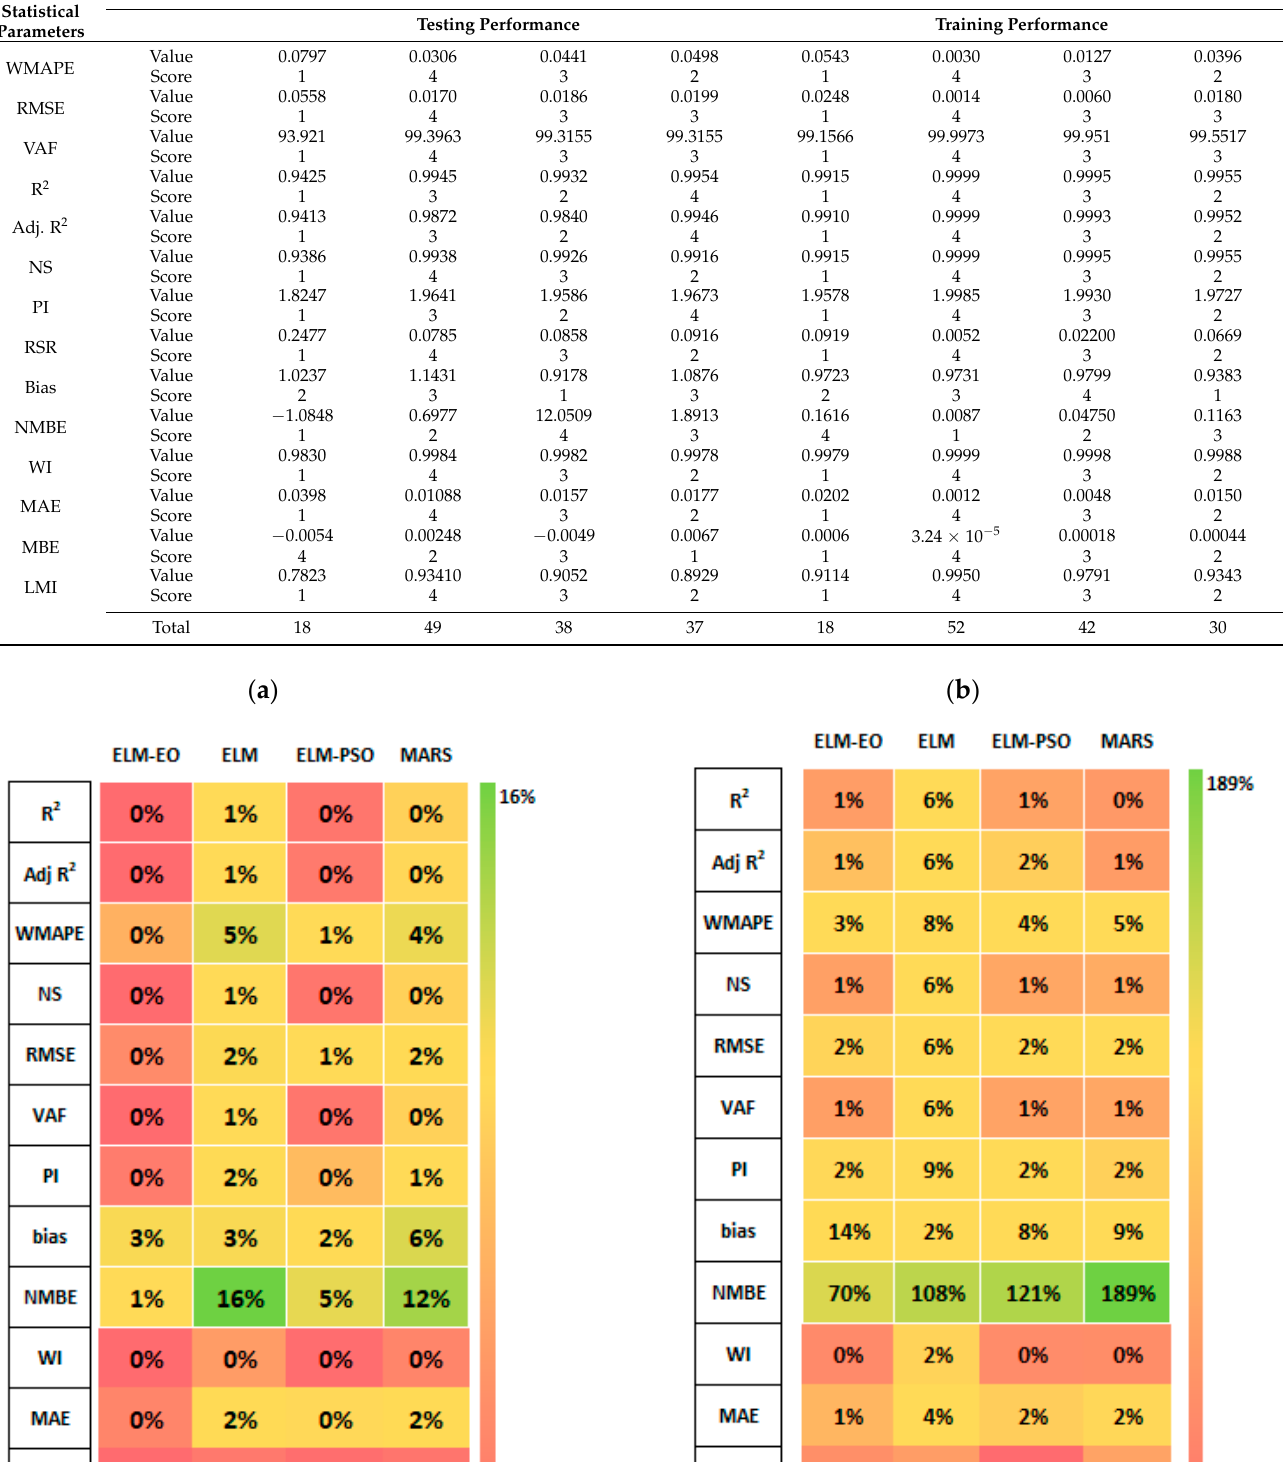
Table 7. Rank analysis of the simulated model outcomes for testing and training dataset.